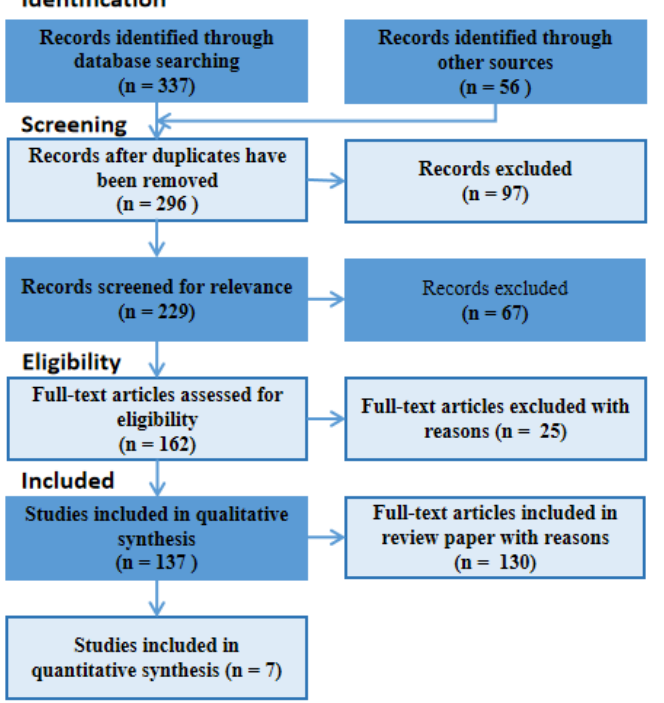
Figure 4. PRISMA flow showing the process of the final selection of the 137 papers at the reference and the 7 specific articles that focused on XAI for IDS in